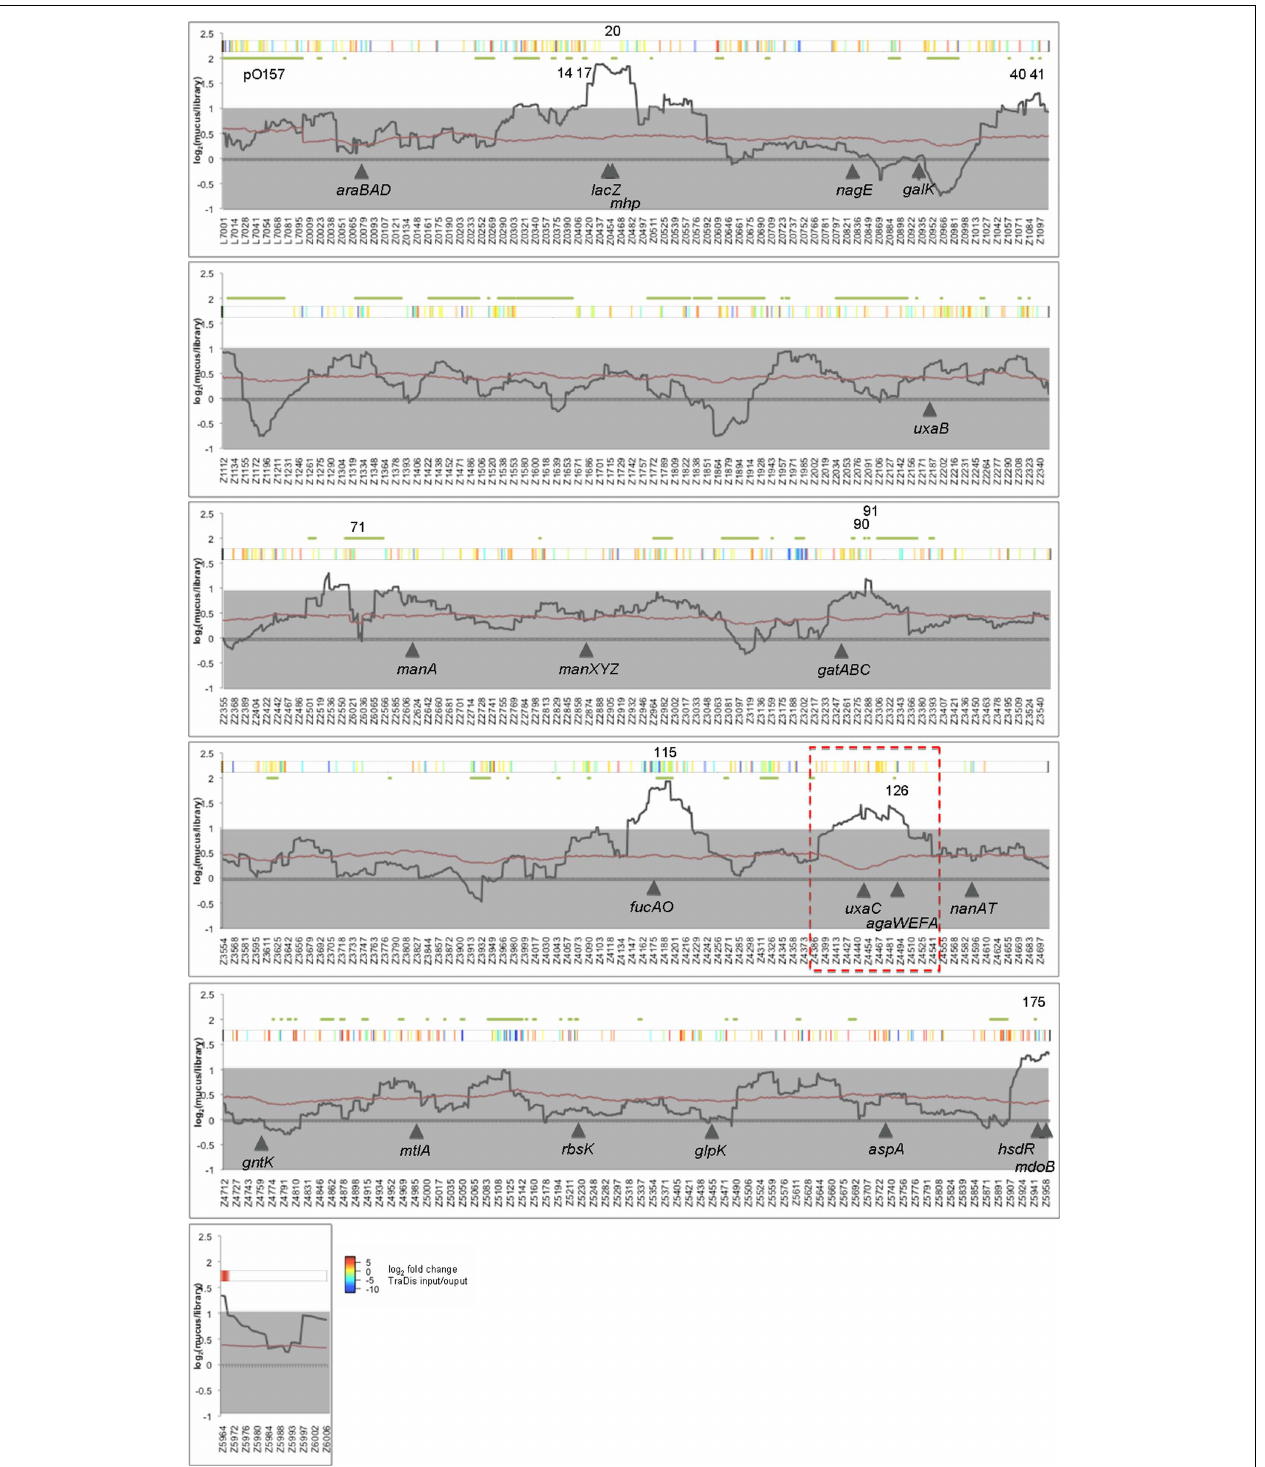
line indicates average average ratio (output/input), the red line indicates the average p value and gray shading indicates an arbitrary two-fold cut-off for significance. Green lines and numbers above the plot indicate the location of O-islands. Solid arrowheads and designations indicate select genes implicated in sugar utilization of E. coli .The red dashed box indicates the region selected for further confirmation (see Figure 4 ).